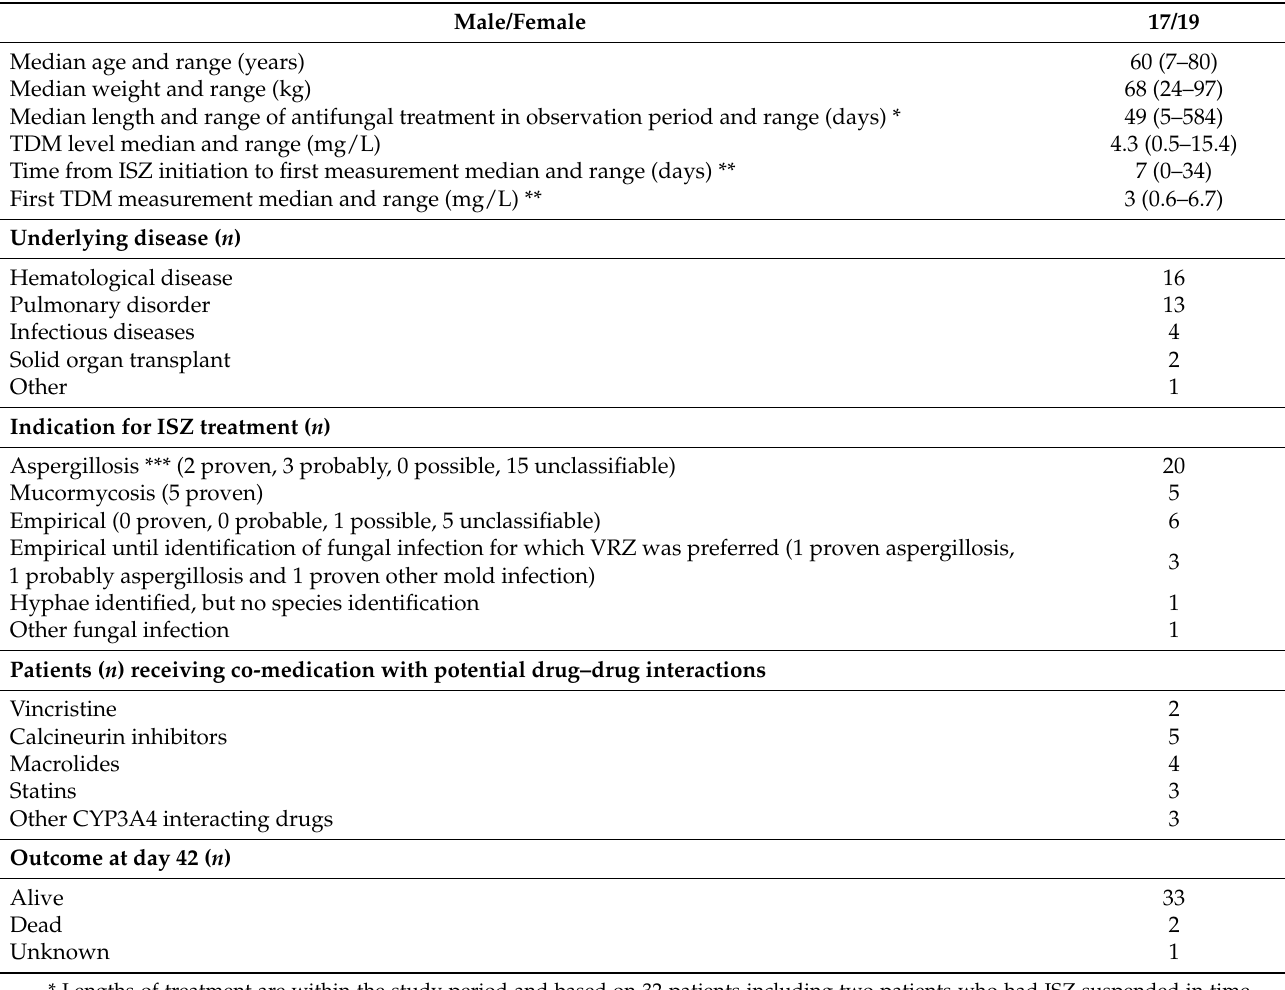
Table 1. Demography and clinical data of patients who received